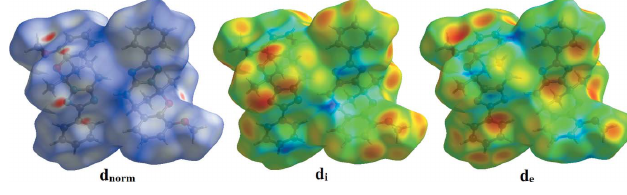
Figure 3 Hirshfeld surfaces of the title compound mapped over d norm , d i and d e .